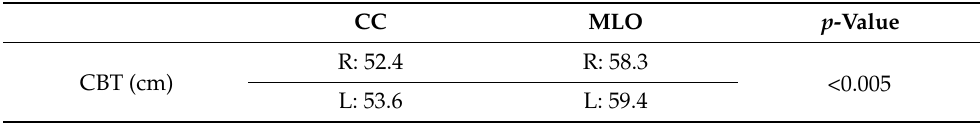
Table 4. The compressed breast thickness (CBT) median in the craniocaudal (CC) and mediolateral oblique (MLO) projections.